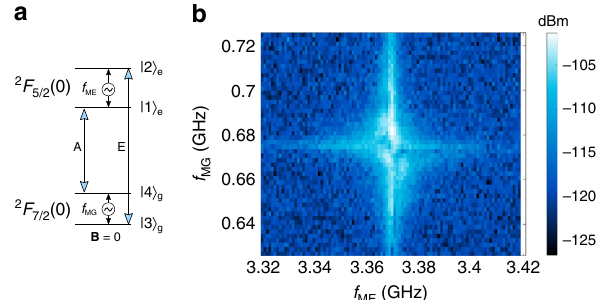
Fig. 4 Four-level system transduction at zero fi eld. a The energy levels used for a four-level magneto-optical transduction scheme at zero magnetic fi eld using 171 Yb 3 + :YVO fi eld at the excited state 4 . The input microwave hyper fi ne transition frequency f ME is transduced to an output optical fi eld resonant with transition E. The ions are pumped by a microwave fi eld resonant with the ground state hyper fi ne transition f MG and an optical fi eld resonant with transition A. b Transduced signal at the frequency of the optical transition E as a function of the two microwave input signals with the detuning of the optical pump Δ optical = 0, which provides an indication of the inhomogeneous broadening of the relevant transitions (detection bandwidth = 30 Hz, optical pump power in the waveguide = 25 µ W, Rabi frequency Ω o ≈ 20 MHz, and microwave power of 3.7 dBm in the coplanar waveguide, Rabi frequency Ω ME ≈ 3 MHz, Ω MG ≈ 10 protocol 2 to enable synchronization of network links. The coherence lifetime of the spin transition T 2 (Spin) sets an upper bound on the potential storage time. Using two-pulse Hahn echoes we measure T 2 (Spin) = 35 µs as | B | → 0 (see Supplemen- tary Note 5), which is suf fi ciently long to enable useful storage relative to the timescales of typical microwave qubit operations (10 – 100 ns). M2O transduction using a four-level system for |B| = 0 . Using a